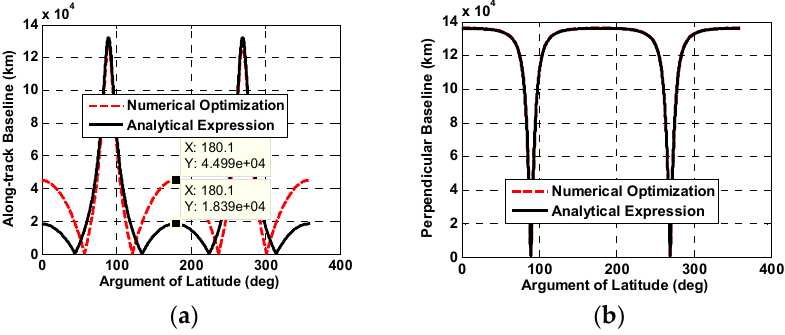
Figure 7. Baseline calculated using ECF equation, ECI equation, and STK data. ( a ) LEO SAR formation; ( b ) MEO SAR formation; ( c ) GEO SAR formation.